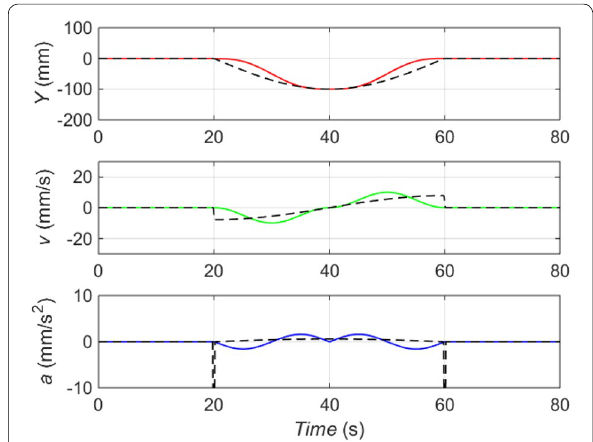
Figure 9 Position, velocity, and acceleration curves of cycloid trajectory planning in the Y direction